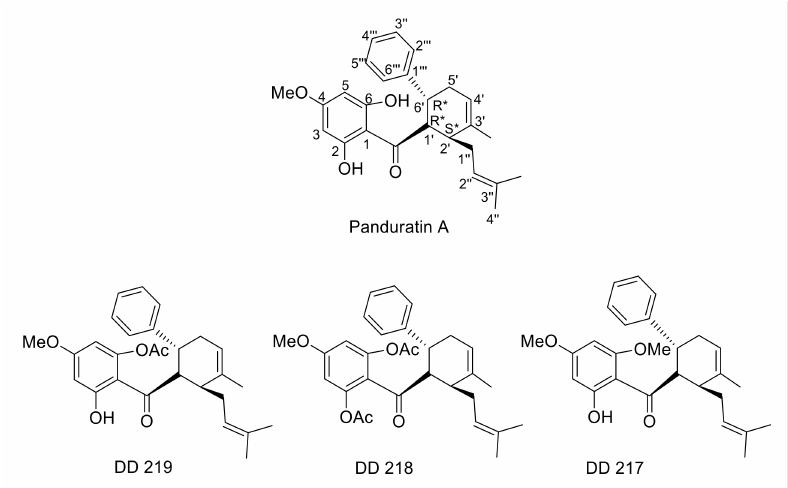
Figure 1. Chemical structures of panduratin A and its